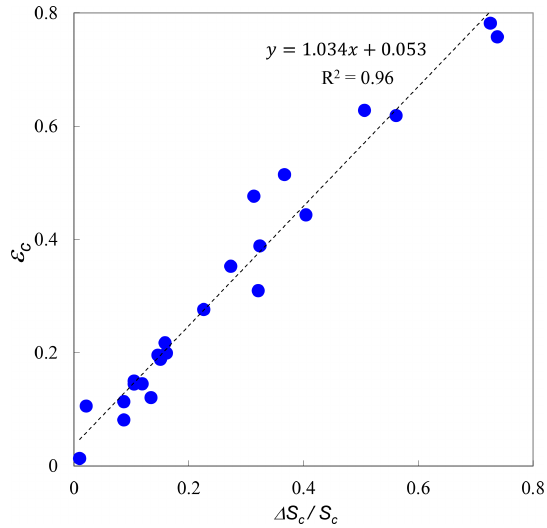
Figure 2. Plot of ε c vs. (cid:49)S c /S c for a variety of simulated opti- cal depth retrievals. The lognormal FM and CM PSDs employed in these simulations were obtained by fitting their sum to retrieved AERinv PSDs over a variety of sites whose predominant aerosol type was urban, dust or marine (and employing the refractive in- dices provided by the retrieval product). The AERinv PSD retrievals were Version 2, for which r 0 was fixed at 0.6µm and, accordingly, for which the ε c vs. (cid:49)S c /S c regression would be only dependent on ε c and second-order parameters such as refractive index (i.e., the plot is independent of r 0